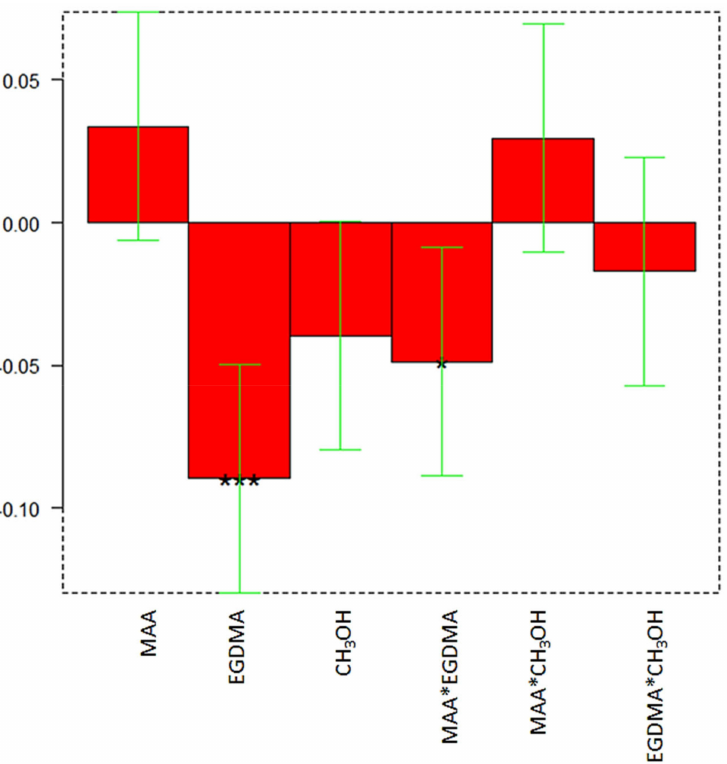
Figure 2. Experimental design to optimize the prepolymeric mixture: coefficients plot. The greatest values and little black stars (regardless of the sign) suggest a significant influence of the respective parameter or interaction and significance (* p ≤ 0.05, *** p ≤ 0.001).